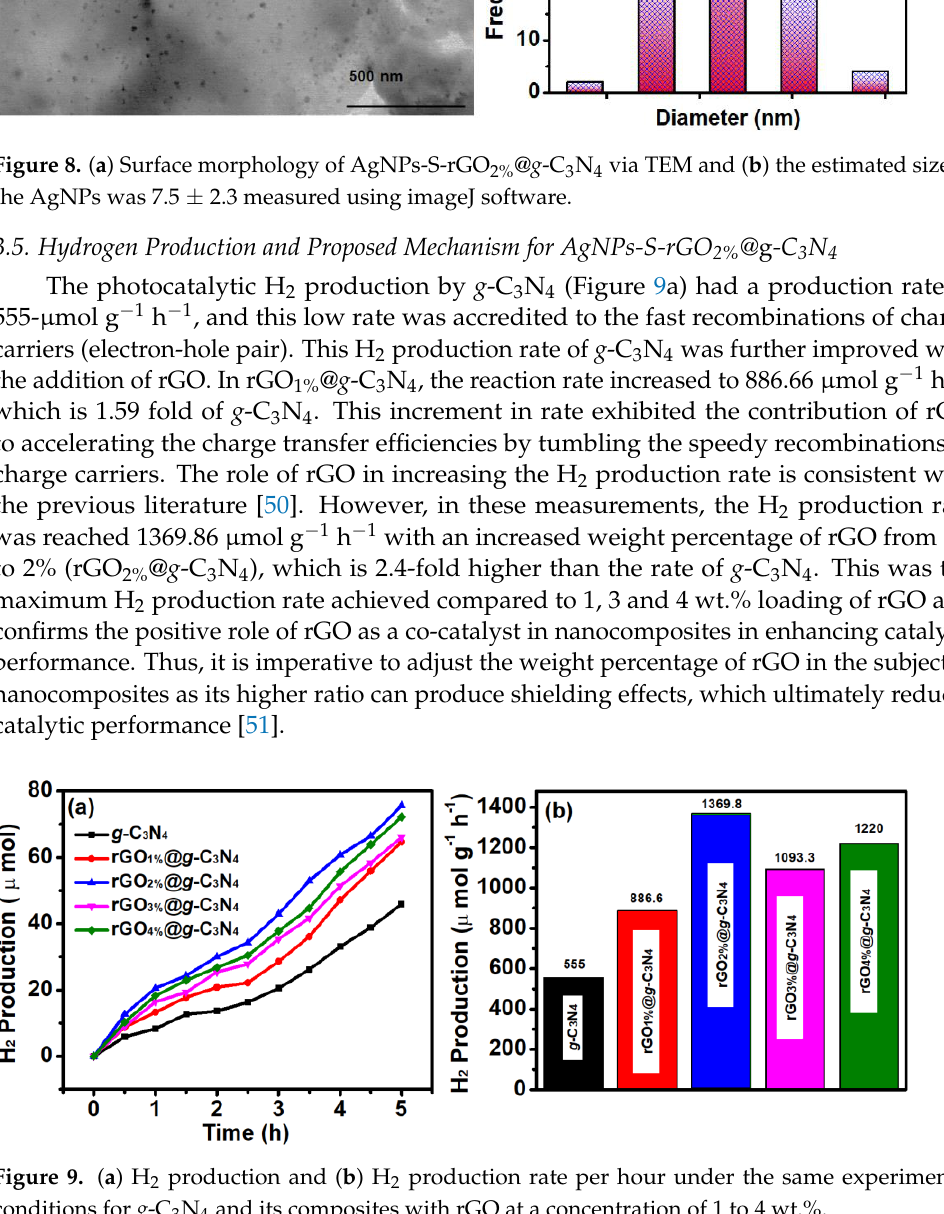
Figure 8. ( a ) Surface morphology of AgNPs-S-rGO 2% @g-C 3 N 4 via TEM and ( b ) the estimated size of the AgNPs was 7.5 ± 2.3 measured using imageJ software.